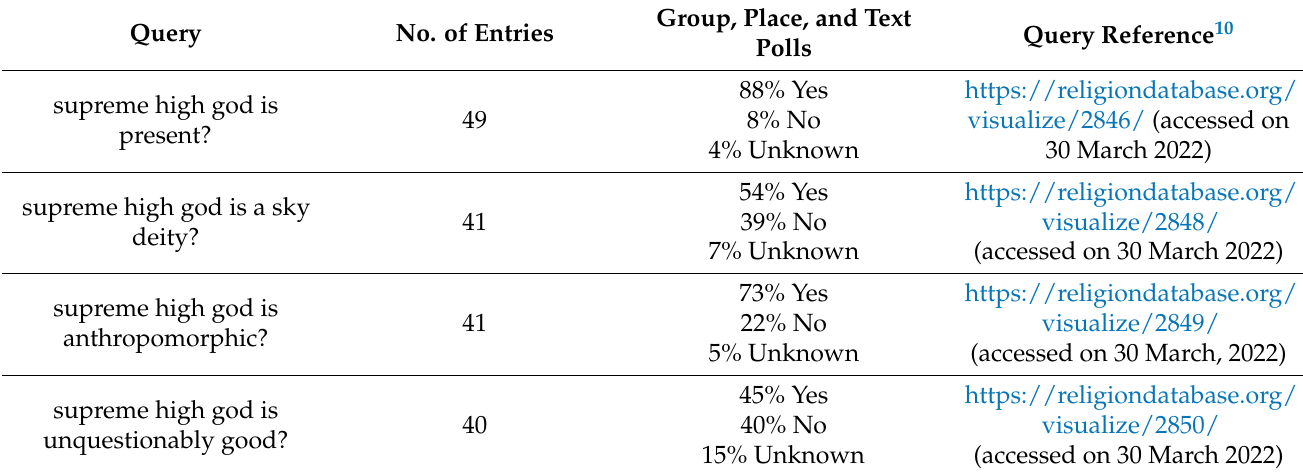
Table 1. Characteristics of supreme high gods in the ancient Near East from 5000–0 BCE using DRH